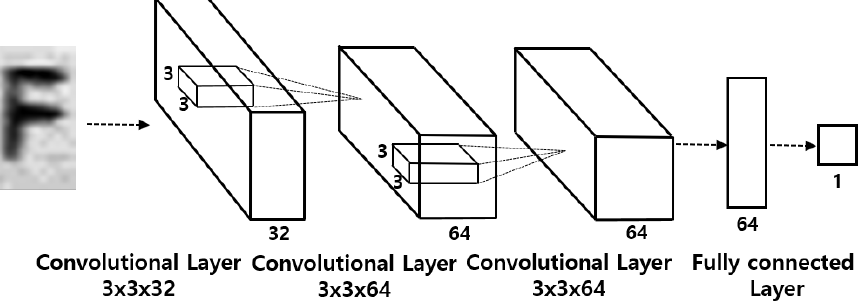
Figure 4. A CNN-based single digit classification